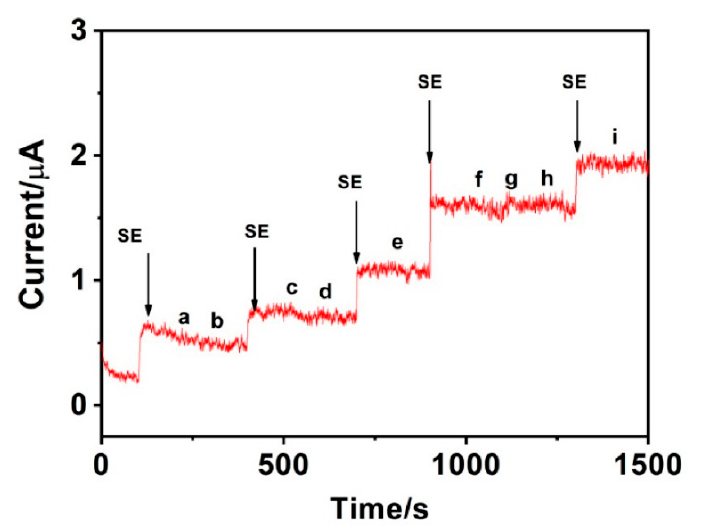
Figure 14. Amperometric response of MnO 2 - graphene (GR) modified glassy carbon electrode (GCE) for the addition of 50 μ M serotonin (SE) and successive addition of interferents 500 μ M each in the sequence of (a) DA, (b) EP (c) folic acid (FA), (d) UA, (e) AA, (f) glucose (g) Na + , (h) K + and (i) Mg 2+ in 0.1 M PBS buffer. Figure reused under the terms of CC-BY license from Ref. [133].